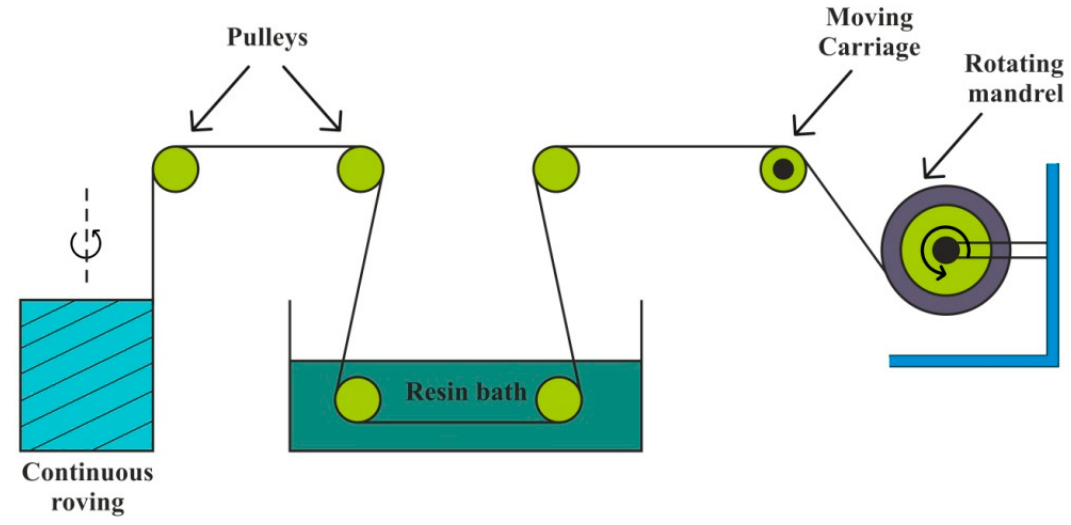
Figure 12. Filament winding.